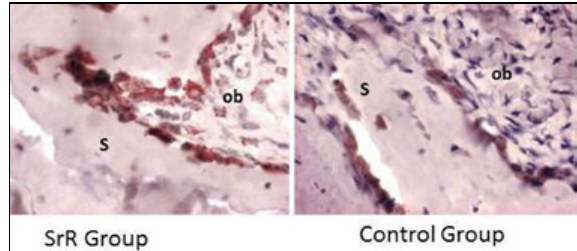
Figure 5. Photomicrographs of immunohistochemical sections from sutural areas stained with anti-osteocalcin antibody. Ob: Osteoblastic activity; S: Sutura connective tissue (40× magnification).